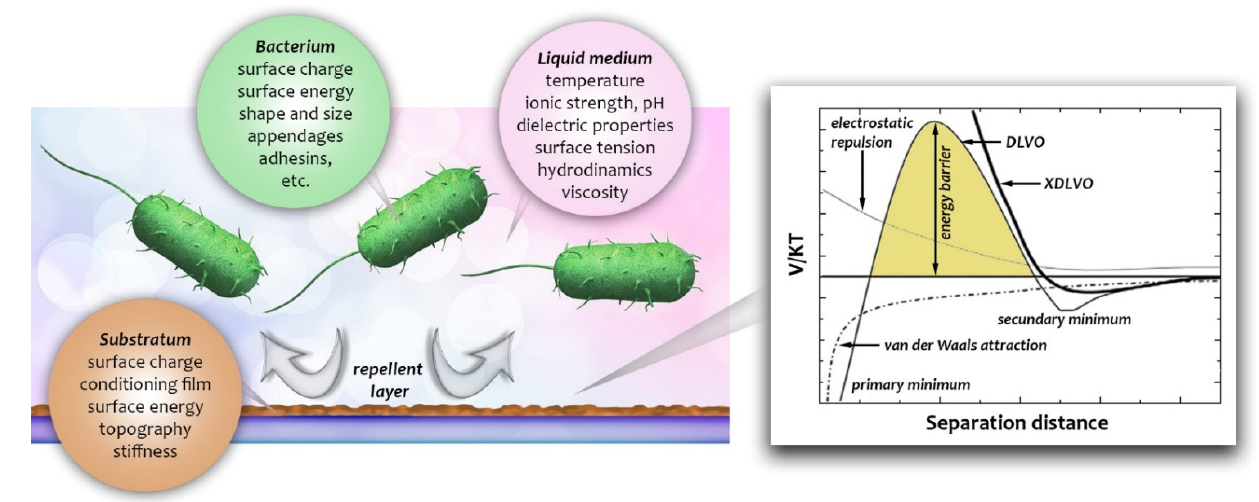
Figure 2. On the left: schematic illustration and the list of the parameters that affect the initial attachment of bacterial cells to a solid–liquid interface (in case of the bacterium, liquid medium and substratum [222,223]). On the right: plotted DLVO and extended DLVO (XDLVO) force graphs based on the figure of Hotze et al. [216], van der Waals force (dashed line), and electrostatic repulsion curves are also shown. V/KT represents the potential energy (V) divided by Boltzmann’s constant (K) and absolute temperature (T) [216].